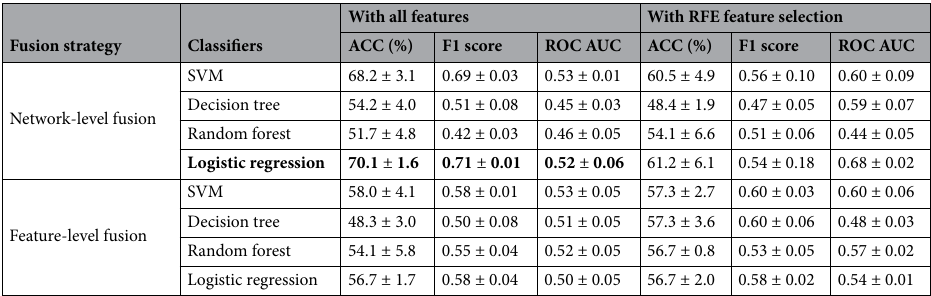
Table 4. Results of linear classifiers on TARGET dataset. Significant values are in bold.